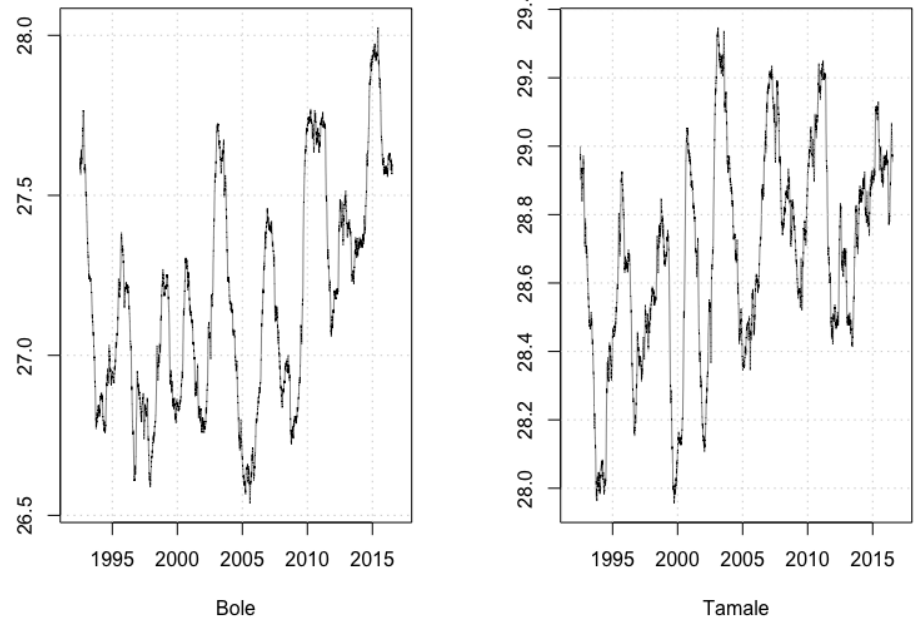
Figure 4. Linear trend of the daily average temperature for Bole and